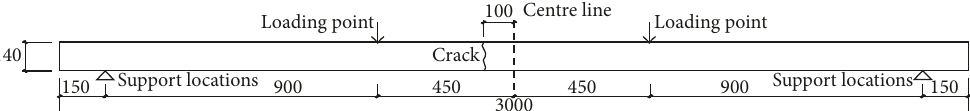
Figure 15: Cracking location (mm).